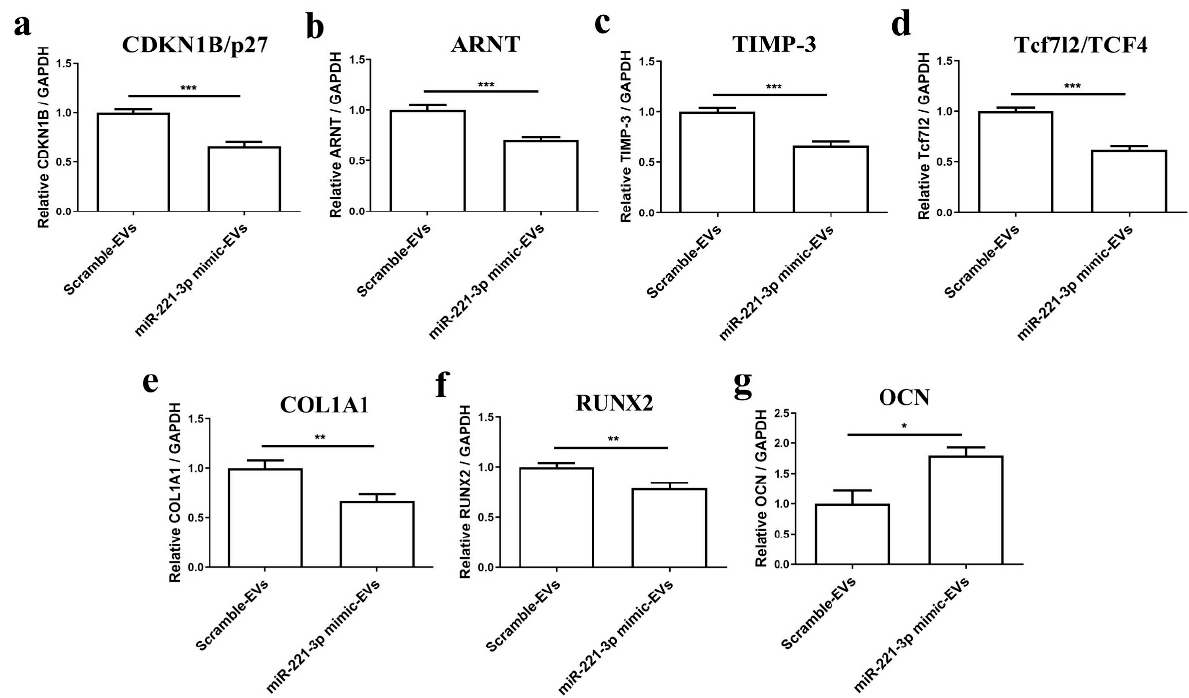
Figure 7. Chondrocytes secreted miR-221-3p-EVs inhibited osteogenic markers and targets expression of miR-221-3p in osteoblasts after 48 h coculture. The expression level of and targets expression ( a – d ) of miR-221-3p CDKN1B/p27, ARNT, TIMP-3, and Tcf7l2/TCF4, and osteogenic markers ( e – g ), COL1A1, RUNX2, and OCN in osteoblasts cocultured with EVs modified by mir-221-3p mimic compared with miRNA scramble after 48 h. Relative to GAPDH., * p < 0.05, ** p < 0.01 and *** p < 0.001 vs. corresponding control.